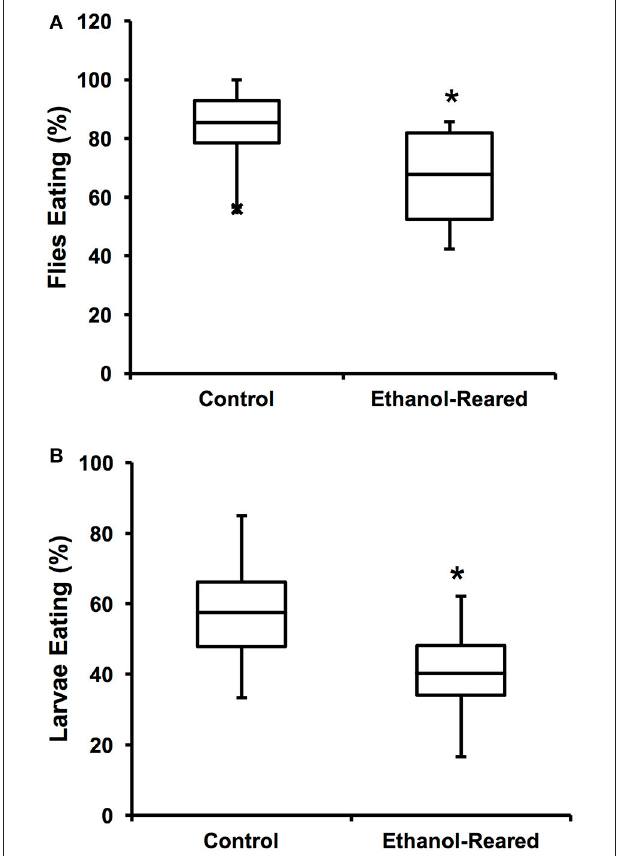
FIGURE 1 | Ethanol-rearing results in reduced feeding. (A) Percentage of adult female flies that ate within a 3-min interval after 6h of food deprivation. ( N = 12 for control, 14 for ethanol-reared. P = 0.0056, Student’s t -Test). (B) Percentage of early third instar larvae that ate within a 20-min interval after 2h of food deprivation ( N = 7, P = 0.035, Student’s t -Test). Center lines show the sample mean; box limits indicate the 25th and 75th percentiles